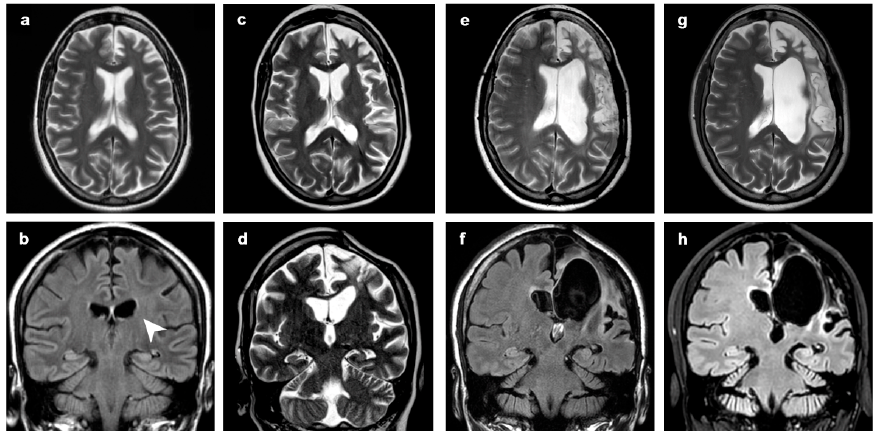
Figure 5. Patient 3, progression of the disease in 17 years. Axial ( a , c , e , g ) and coronal ( d ) T2-weighted images, coronal FLAIR ( b , f , h ) at ( a , b ) 2 years, ( c , d ) 5 years, ( e , f ) 10 years and ( g , h ) 17 years from clinical onset. In the first MRI ( a , b ), only subtle dilatation of left ventricle (arrowhead) and enlarge- ment of frontal sulci could be seen. In ( d ), WM hyperintensity preceded the later atrophic change. Surgical treatment was performed at 6 years from onset, between ( c , d ) and ( e , f ); after surgery, EPC was controlled. At last follow-up, seizures and cognitive and behavioral disorders were present.